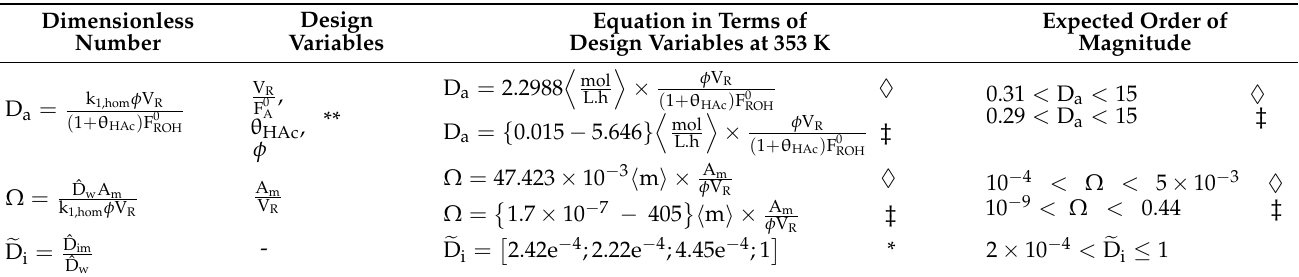
Table 3. Dimensionless numbers and design variable ranges at 353 K, with a θ HAc = 1 (stoichiometric amount of fed reactants) for the esterification reaction of acetic acid with isoamyl alcohol. Design Dimensionless Equation in Terms of Variables Number Design Variables at 353 K